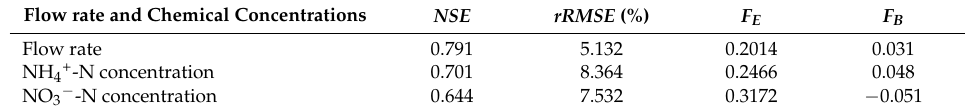
Table 4. Indexes to quantify the accuracy of the simulated flow and transport processes a .